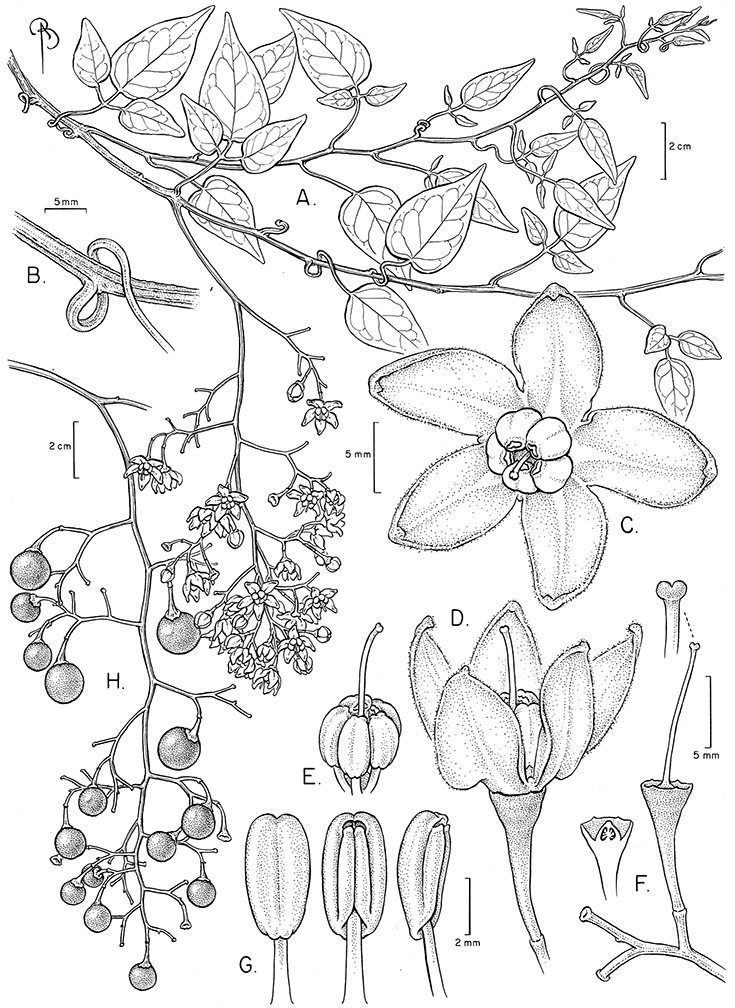
Solanum boldoense Dunal & A.DC. (A–G drawn from Clark 10597 and J. Clark photographs taken in the field H drawn from Wright 381, NY). Illustration by Bobbi Angell.